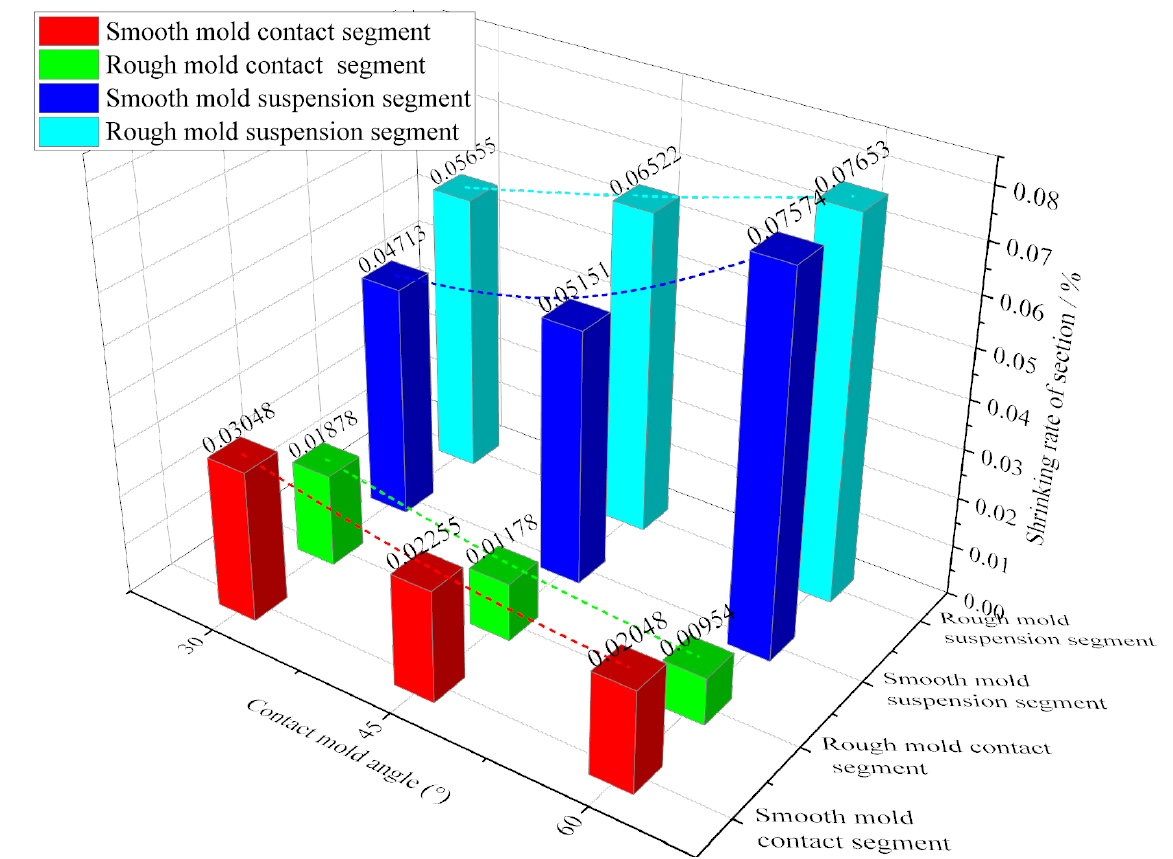
Figure 14. Cross-section shrinkage distribution of the contact mold segment and the suspension segment with different contact mold angles.